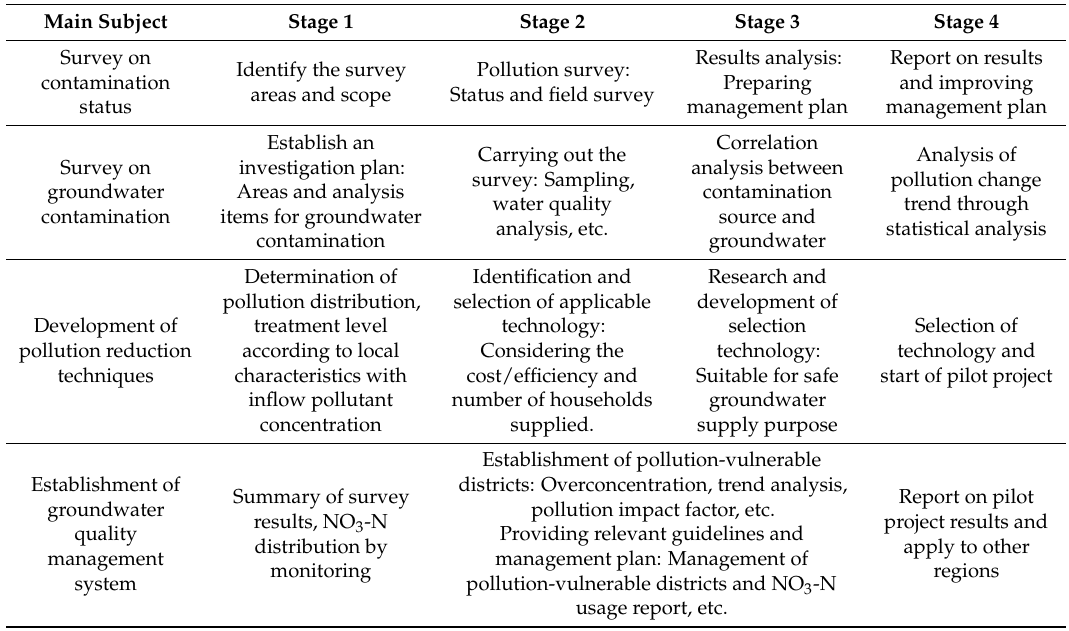
Table 15. Roadmap for stepwise water quality conservation for safe groundwater quality